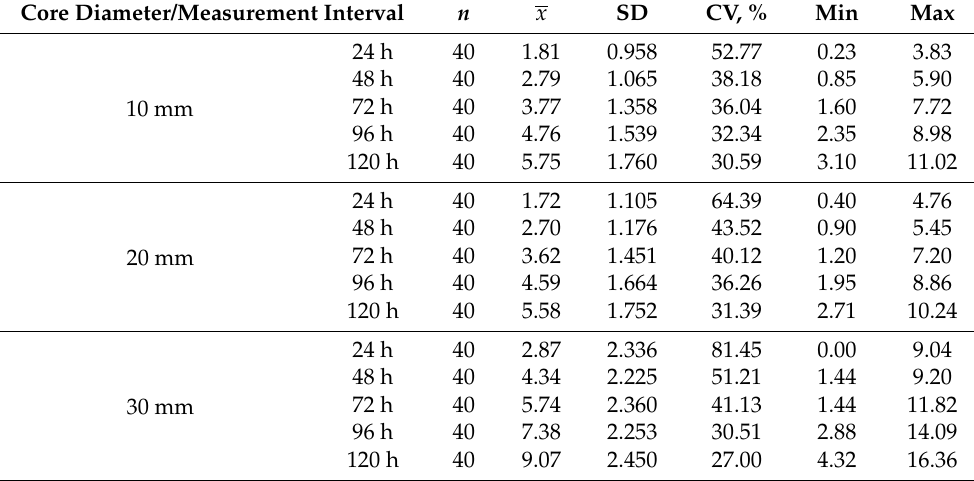
Table 1. Means ( x ) with standard deviation (SD), coefficients of variation (CV), minimum (Min), and maximum (Max) for the drip loss of chicken breast meat in relation to vertical fiber direction, core diameter (10, 20, and 30 mm), and measurement interval (24, 48, 72, 96, and 120 h). Core Diameter/Measurement Interval